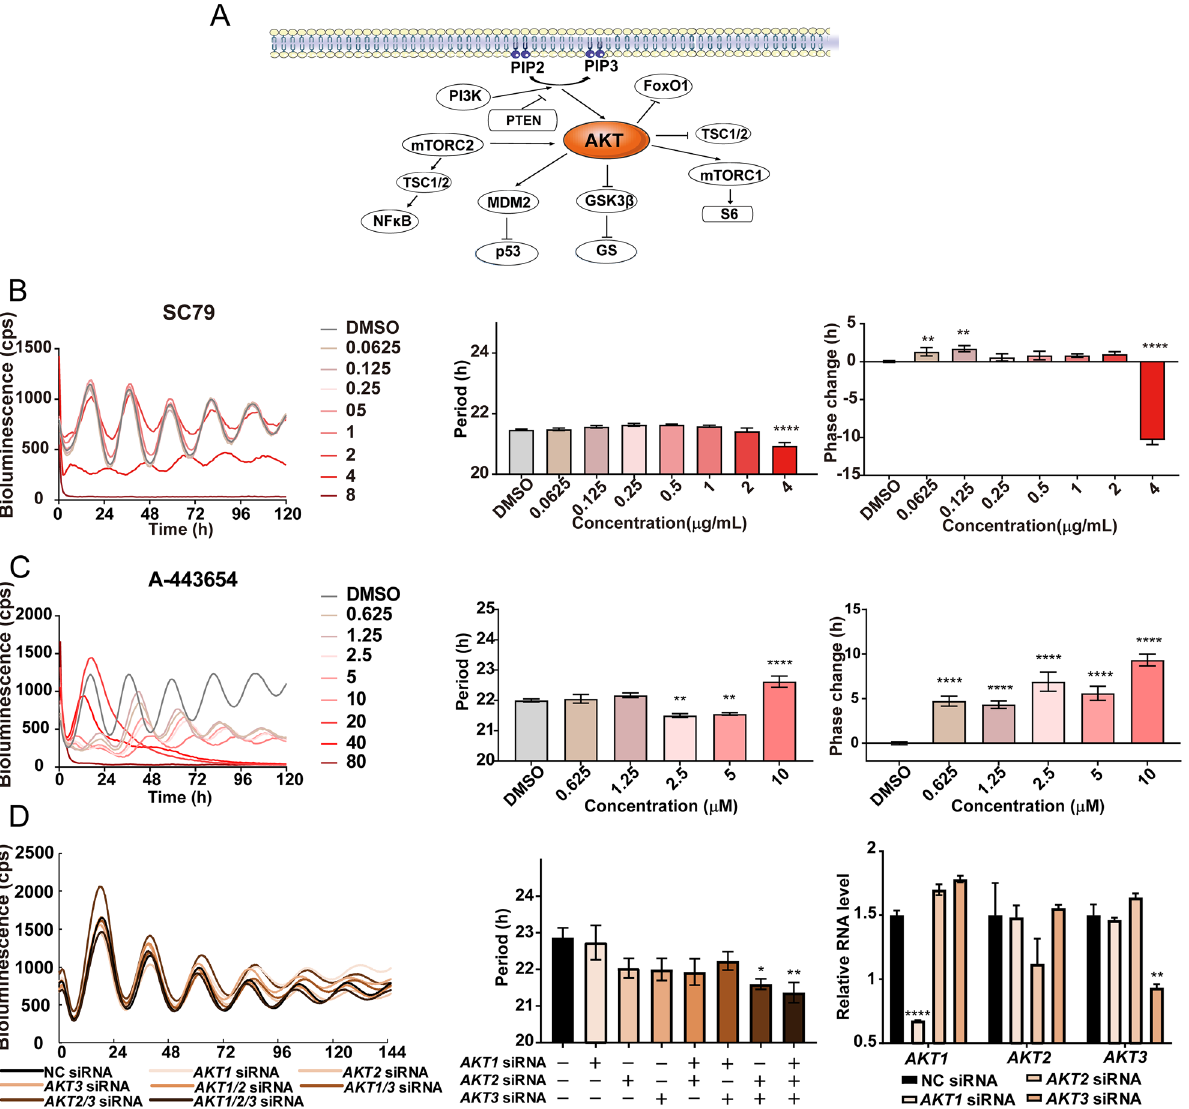
Figure 6. Involvement of AKT signaling in the circadian rhythm. ( A ) Schematic of interactions of the AKT pathway. ( B , C ) Effects of AKT activator SC79 ( B ) and AKT inhibitor A-443654 ( C ) at different concentration. Luminescent traces (left) and dose-dependent effects on period (middle) and phase (right) in U2OS cells. ( D ) Effects of the knockdown of AKT1/2/3 by siRNA. U2OS cells were transfected with negative control (NC) siRNA, AKT1 siRNA, AKT2 siRNA, or AKT3 siRNA. Luminescent traces (left) and effects on circadian period (middle) in U2OS cells. Efficiency of knockdown of AKT was confirmed using RT-qPCR (right). Values are the averages of six replicates ± SD and were analyzed using one way ANOVA, followed by Dunnett’s multiple comparisons test (* p < 0.05, ** p < 0.01, *** p < 0.001, **** p <